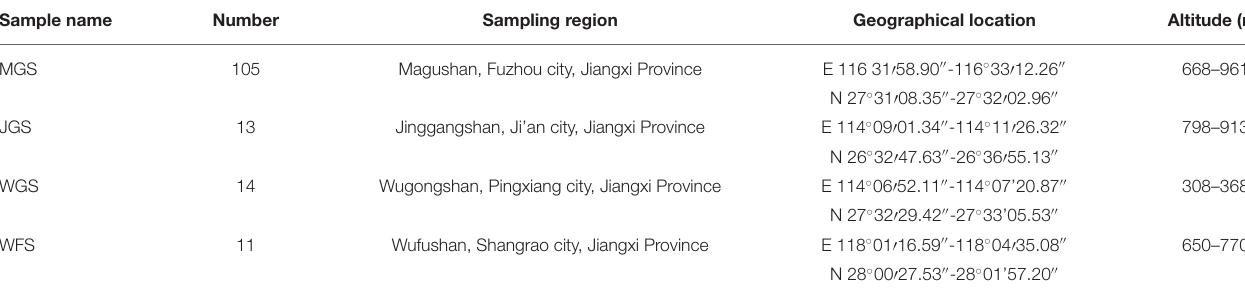
TABLE 1 | Sample information on male Actinidia eriantha